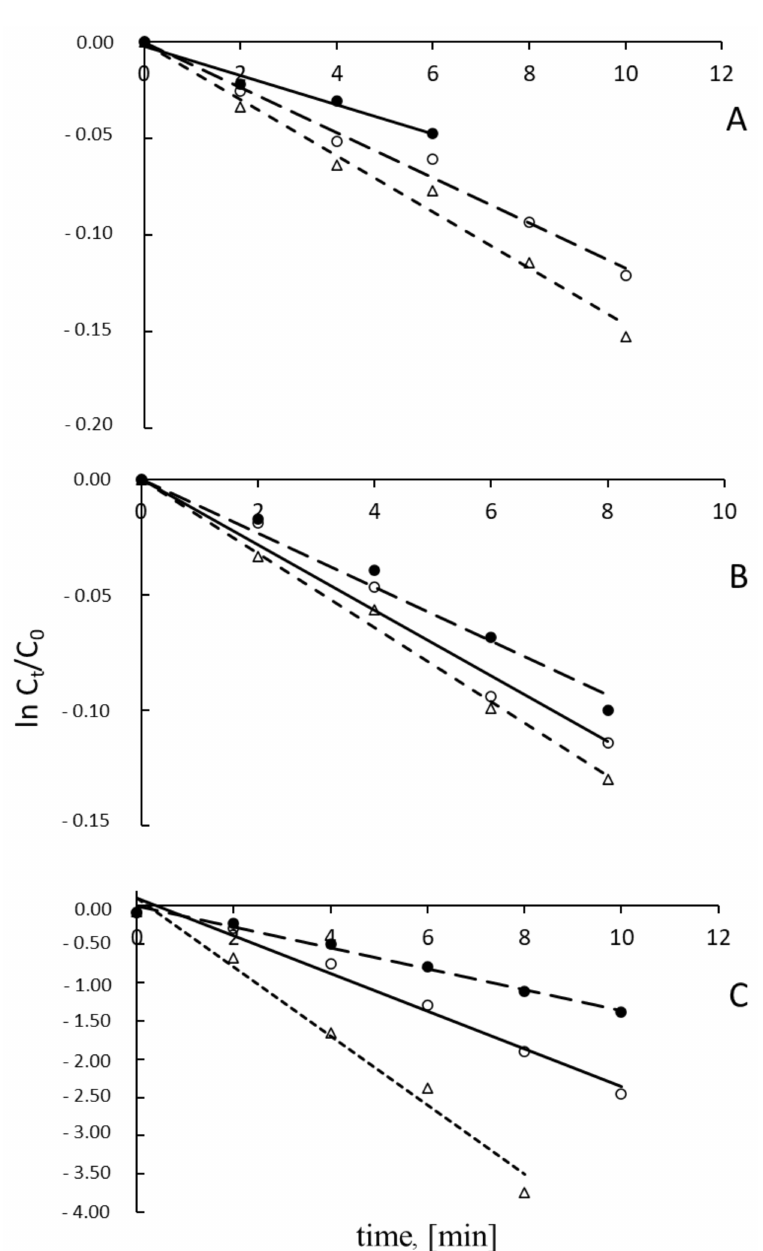
Figure 5. First-order plot of the relative concentrations (C/C 0 ) vs. time, obtained upon illumination of air-saturated aqueous solutions, pH 10, 2.0 × 10 − 4 mol dm − 3 of the test-compounds: I ( A ), II ( B ), and III ( C ) with suspended particles of the photocatalysts. The filled circle ( • ) represents the compounds in the S0-catalyst suspensions, the open circle (o) in the S1-catalyst suspension, while open in the triangle ( ∆ ) S2-catalyst